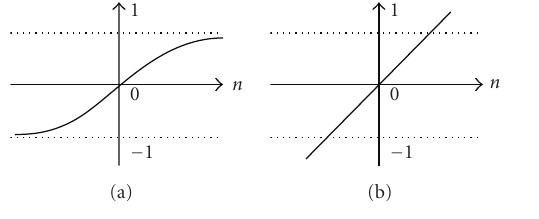
Figure 2: Activation functions: (a) Tangent-sigmoid function, (b) Linear function.